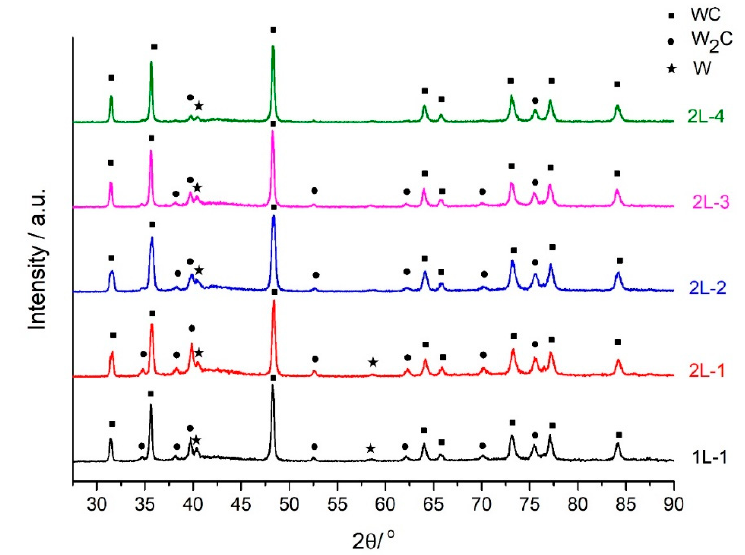
Figure 7. The X-ray di ff raction measurements (DRX) di ff raction patterns of 1L-1, 2L-1, 2L-2, 2L-3, and 2L-4 sprayed